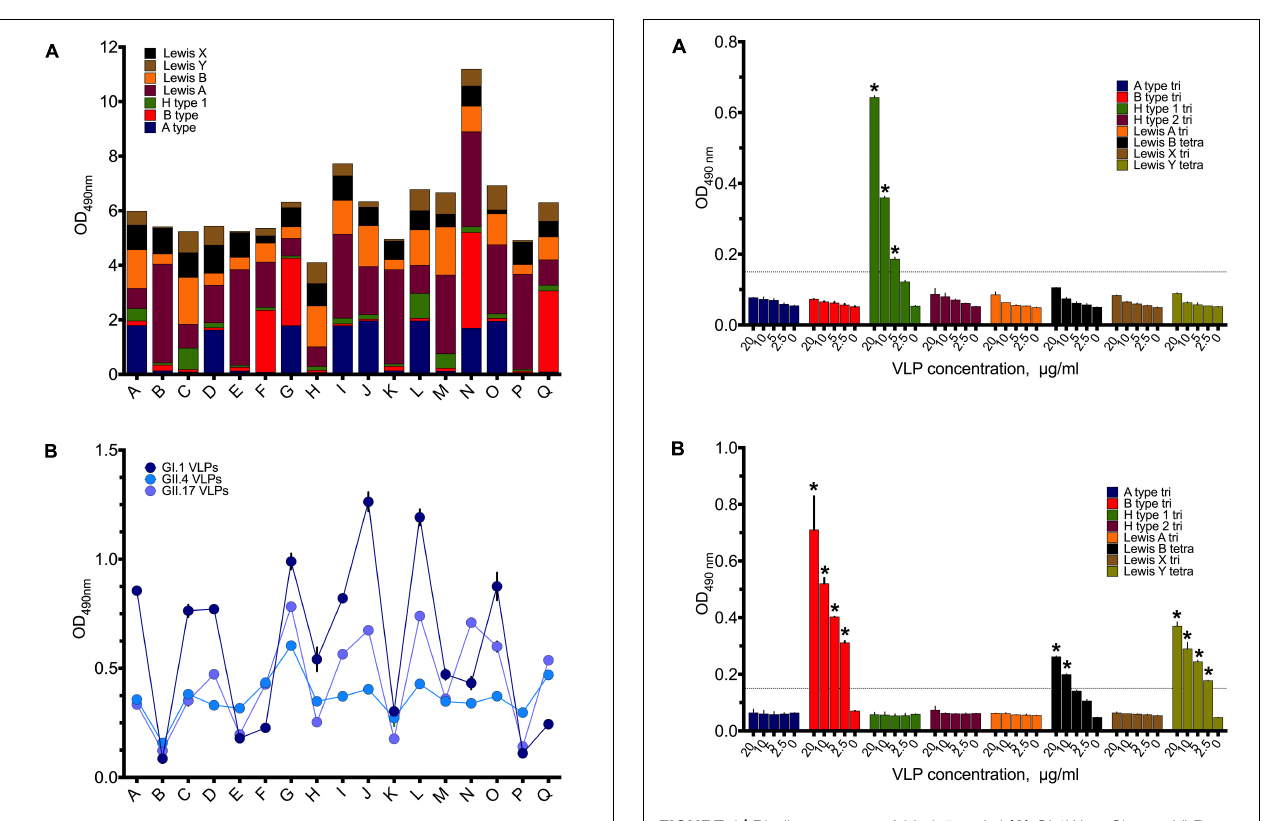
FIGURE 3 | (A) Expression of ABH and Lewis antigens in saliva samples (A–Q). (B) The binding of GI.1 West Chester VLPs, GII.4 Sydney VLPs, and